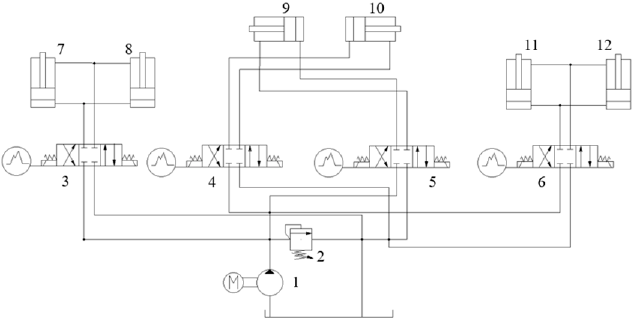
Figure 5. Schematic diagram of the hydraulic system of the extendable working platform and fruit box. 1 represents the hydraulic pump; 2 represents the unloading valve; 3, 4, 5, and 6 represent the solenoid directional valve; 7, 8, 11, and 12 represent the lifting hydraulic cylinders; 9 and 10 represent the extension hydraulic